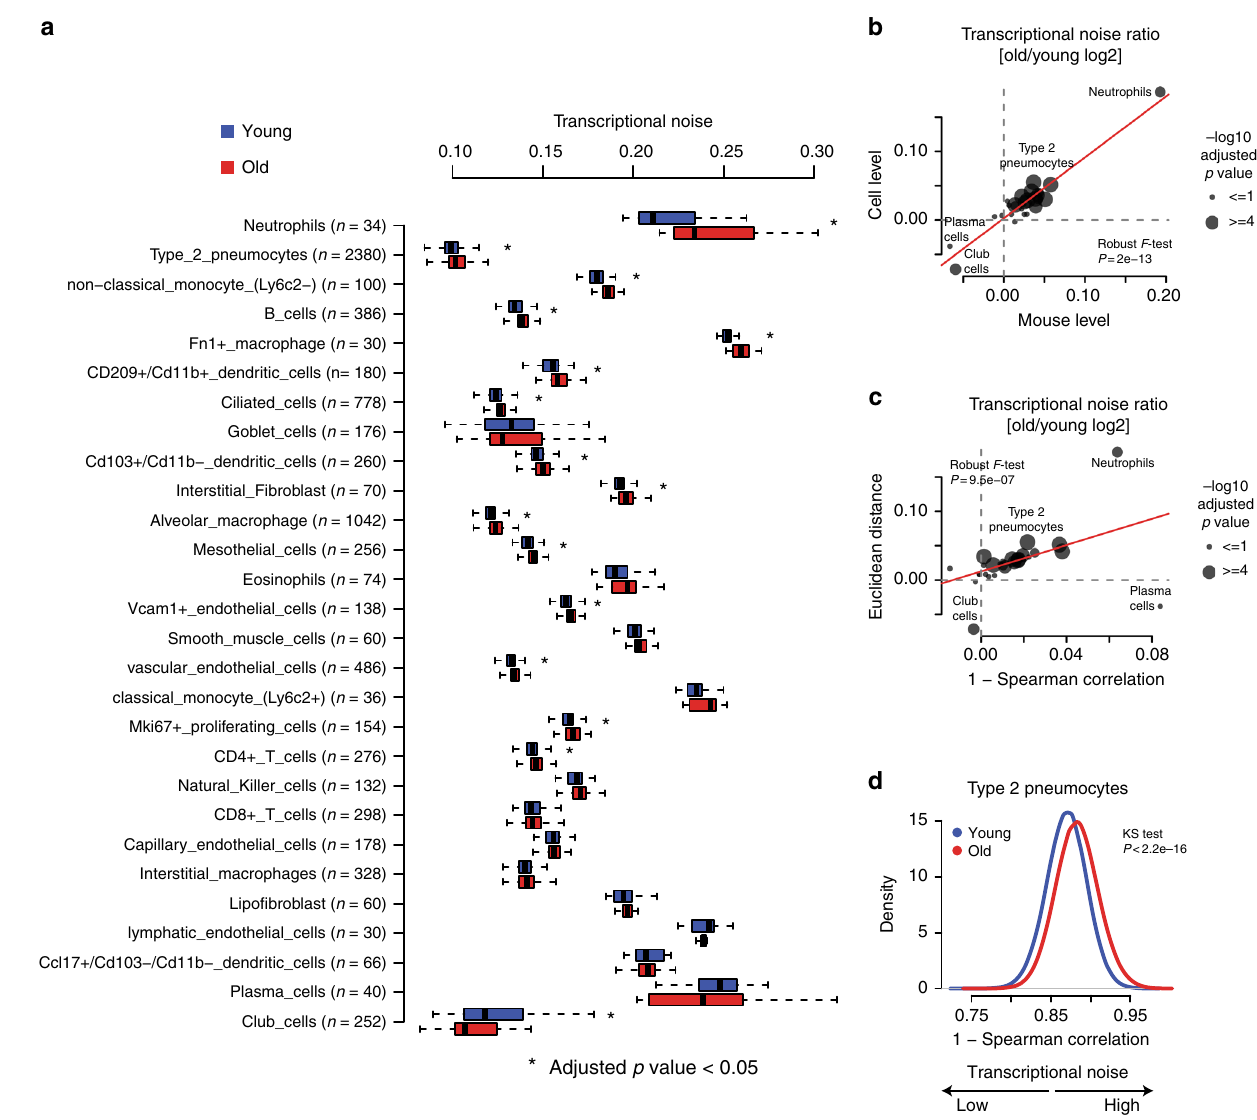
Fig. 2 Most cell types show increased transcriptional noise with aging. a Boxplot illustrates transcriptional noise by age and cell type for the indicated number of cells. For all boxplots, the box represents the interquartile range, the horizontal line in the box is the median, and the whiskers represent 1.5 times the interquartile range. Blue and red colors indicate young and old cells, respectively. Asterisk indicates signi fi cant changes (Wilcoxon ’ s rank sum test, adjusted p value < 0.05). Cell types are ordered by decreasing transcriptional noise ratio between old and young cells. b Scatterplot shows the log2 ratio of transcriptional noise between old and young samples as calculated using mouse averages ( n = 15) and single cells on the X and Y axes, respectively. c Scatterplot depicts the log2 ratio of transcriptional noise between old and young samples as calculated using 1 – Spearman correlation and the Euclidean distance between cells on the X and Y axes, respectively. For both panels, the size of the dots corresponds to the negative log10 adjusted p value of the cell type-resolved differential transcriptional noise test and the red lines correspond to the robust linear model regression fi t. d As an example, the distribution of 1 – Spearman correlation coef fi cients between all pairs of young and old cells is shown for type-2 pneumocytes. Larger values represent increased transcriptional noise. Blue and red colors indicate young and old